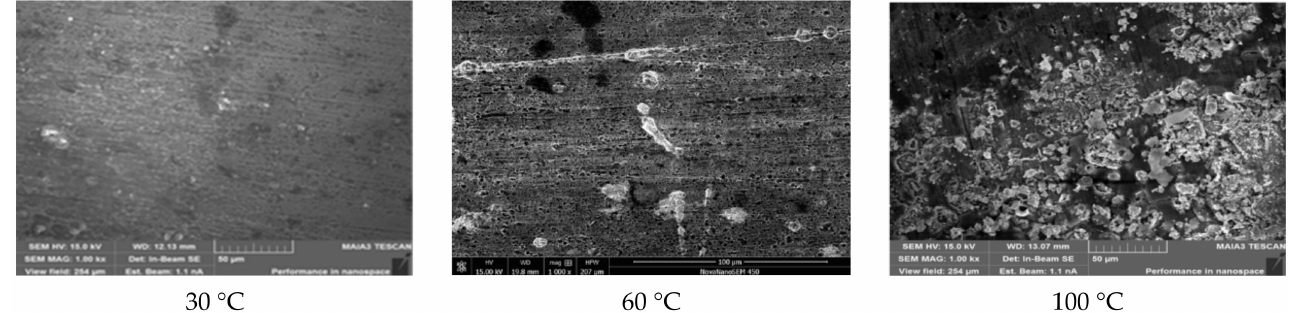
Figure 4. Surface microscopic corrosion profiles of 80S steel at different temperatures with pressure of 20